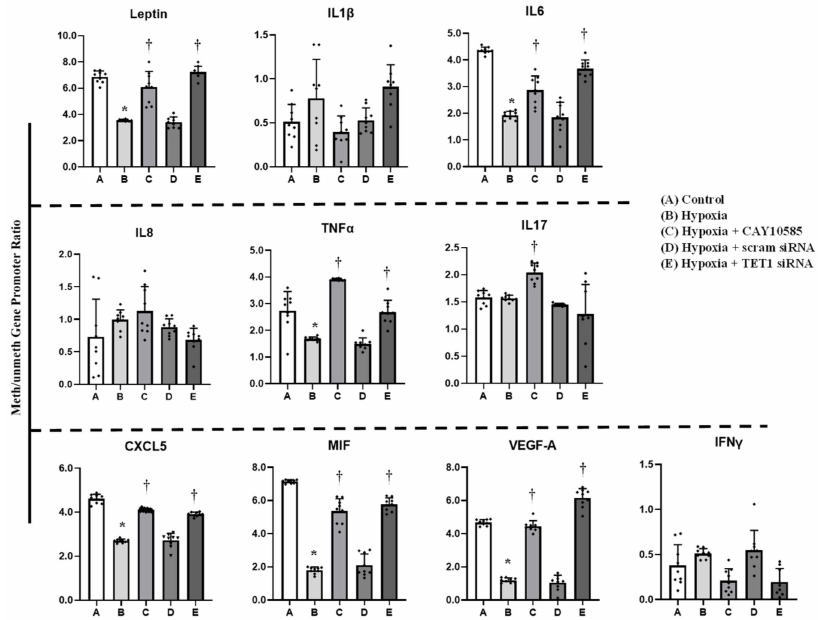
Figure 4. E ff ect of hypoxia and HIF1 α / TET1 pathway on adipocytokine promoter methylation. Methylation-specific PCR analysis of the methylated / unmethylated ratios of leptin, IL1 β , IL6, IL8, TNF α , IL17, CXCL5, MIF, VEGFA, and IFN γ in adipocytes that were cultured for 24 h under conditions of hypoxia ± CAY10585 or silenced TET1 compared to standard culturing conditions (control). Results represent the means ± SD for three independent experiments in triplicates for each treatment (n = 9). (* p < 0.05) for comparison with control and ( † p < 0.05) for comparison with